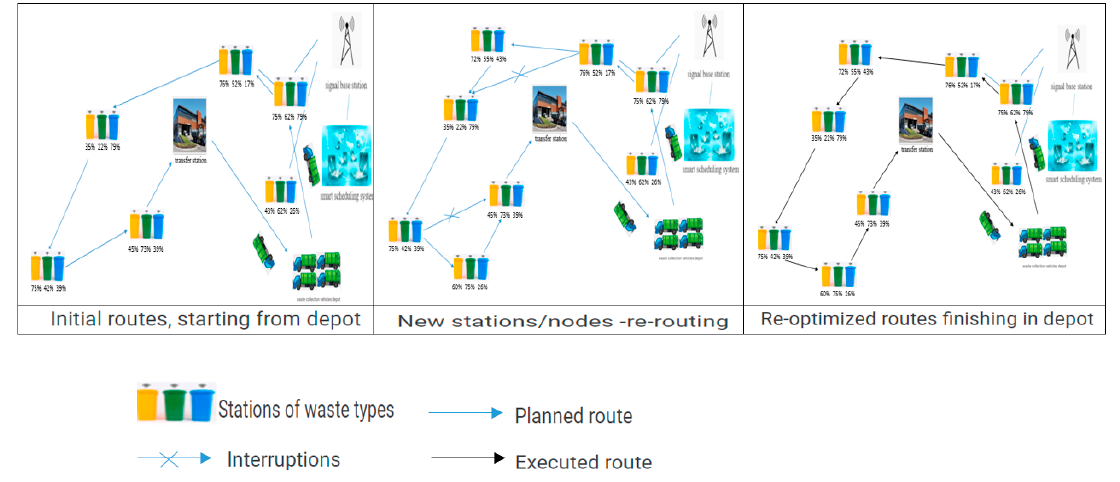
Figure 1. Dynamic vehicle routing for separate and smart waste collection.